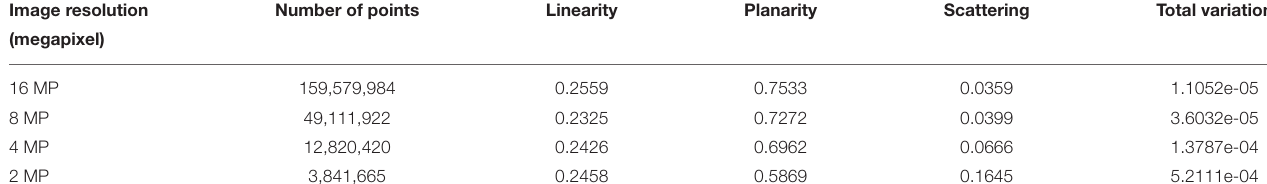
TABLE 5 | Bay #5 model analysis using mean values of dimensionality features.